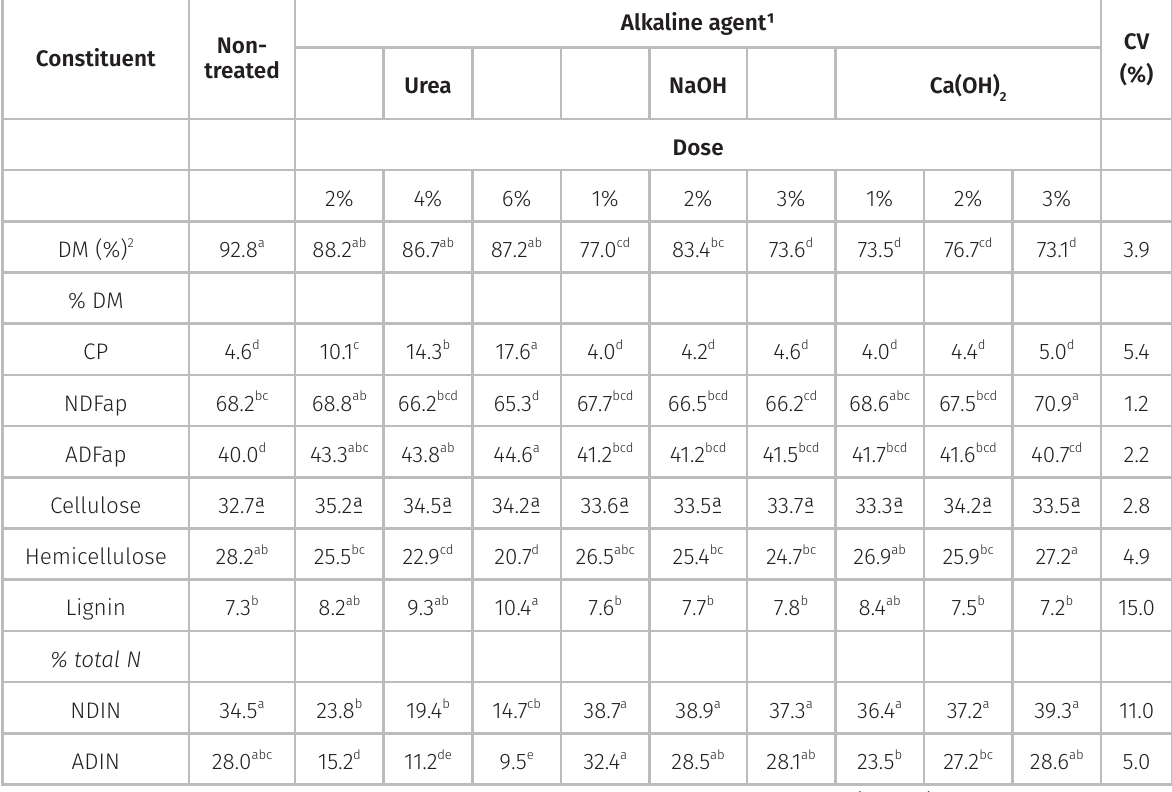
Table I. Chemical composition of sugarcane tip hay treated or not with alkaline agents. Non- Constituent treated